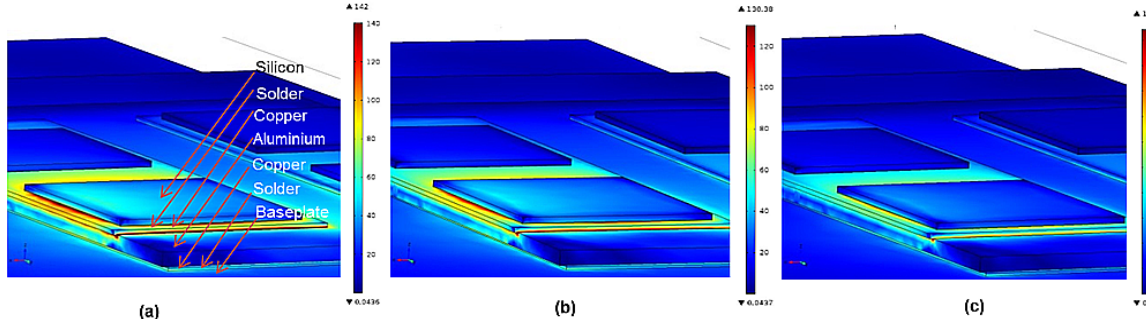
Figure 14. Surface von Mises stress for FS based BTB converter’s generator side power module with ( a ) fixed DC link; ( b ) dynamic DC link without and ( c ) with switching frequency